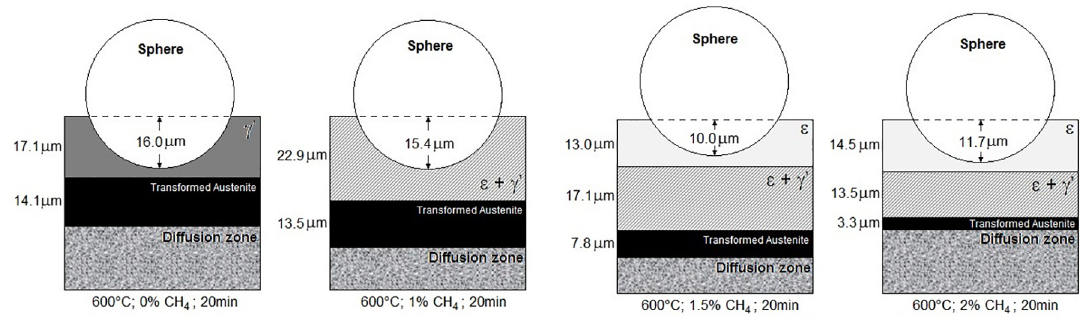
Figure 11. Schematic illustration of wear crater depth (temperature of 600°C and 20 minutes